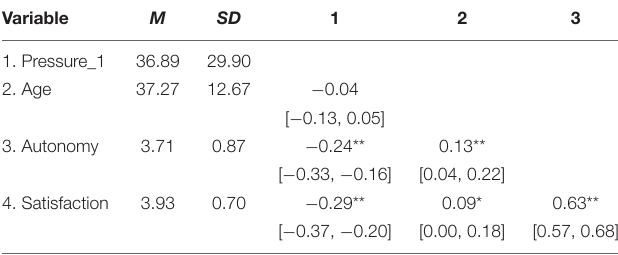
TABLE 1 | Means, standard deviations, and correlations with confidence